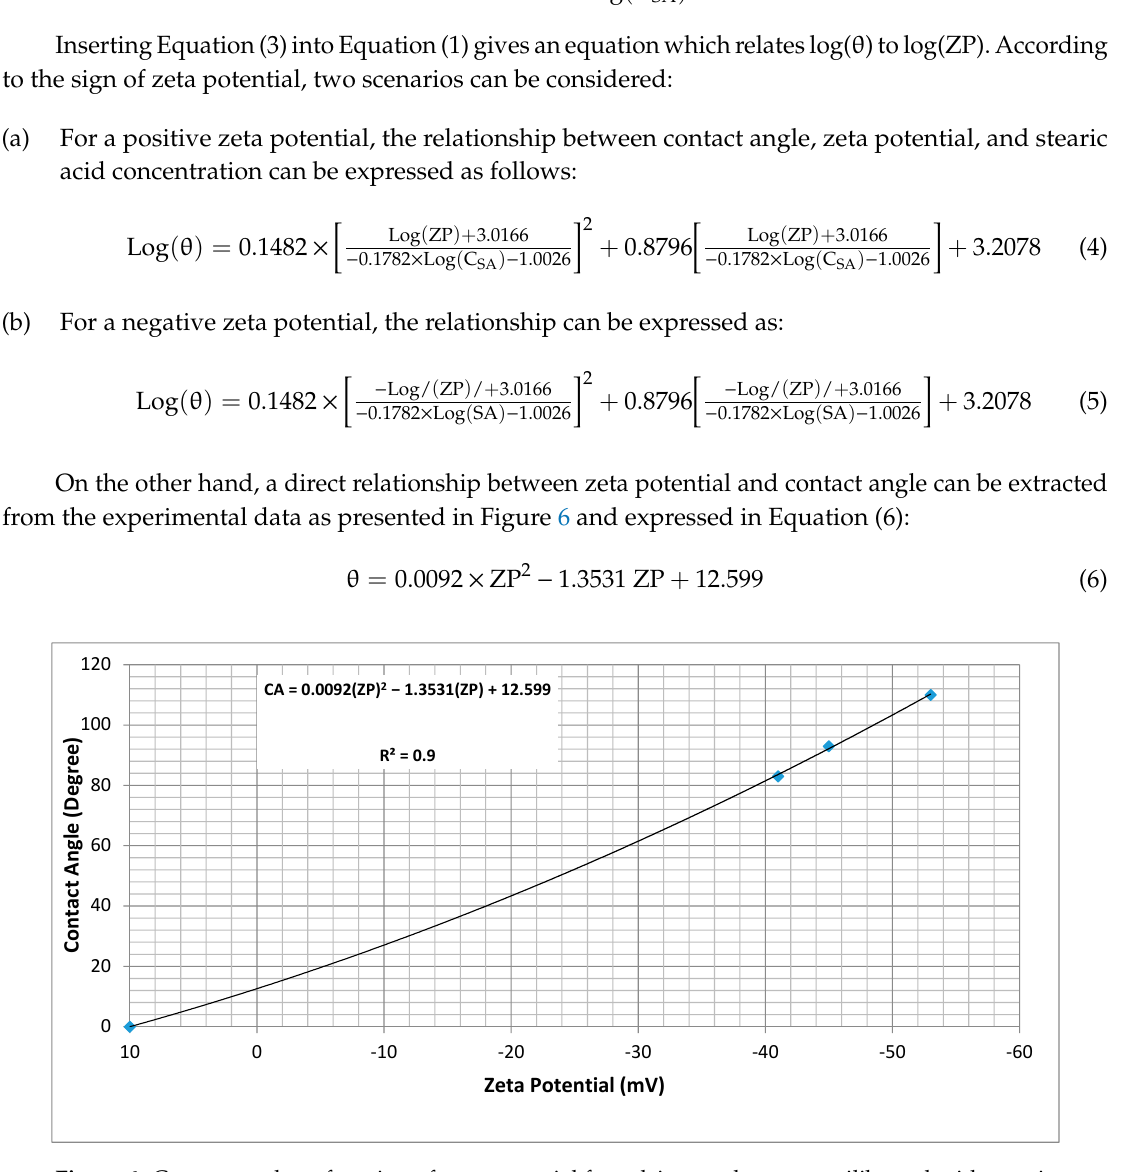
Figure 6. Contact angle as function of zeta potential for calcium carbonate equilibrated with stearic acid in a n -decane solution in the presence of water.